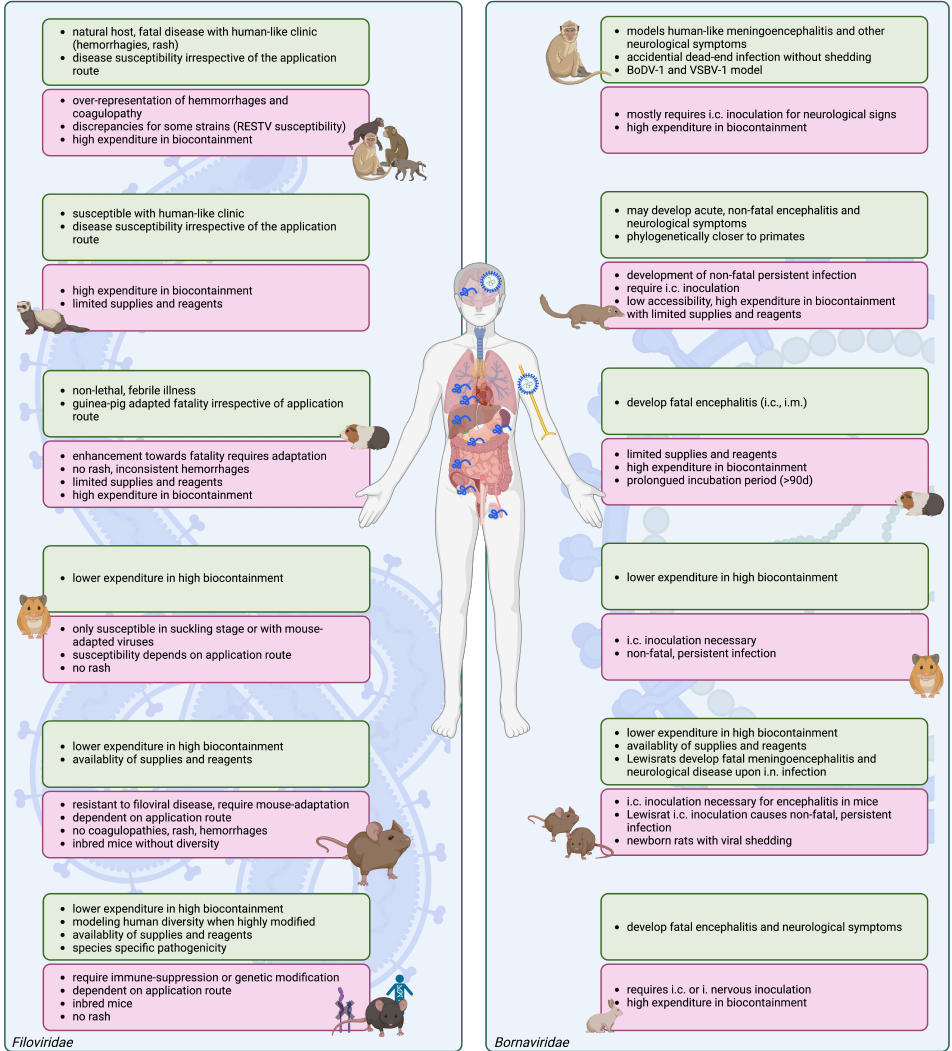
Figure 1. Capabilities and limitations of established animal models in filovirus and bornavirus disease. Scheme of human-pathogenic Filoviridae and Bornaviridae animal models. Left: Filovirus animal models: non-human primates, ferrets, guinea pigs, hamsters, wild-type mice, and immune- deficient or humanized mice. Right: common animal models for human bornavirus encephalitis including non-human primates, shrews, guinea pigs, hamsters, mice, rats, and rabbits. Expenditure summarizes cost, availability, personnel and space requirements. Created with